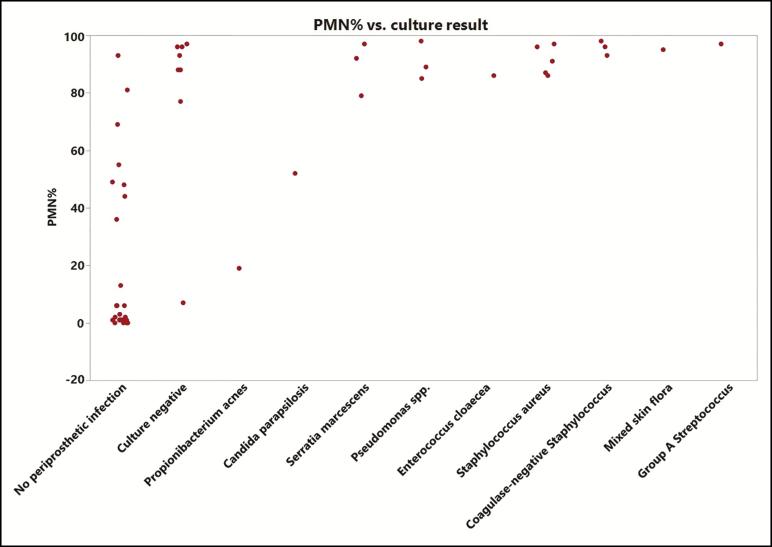
Neutrophil percentage (PMN%) by associated culture results.